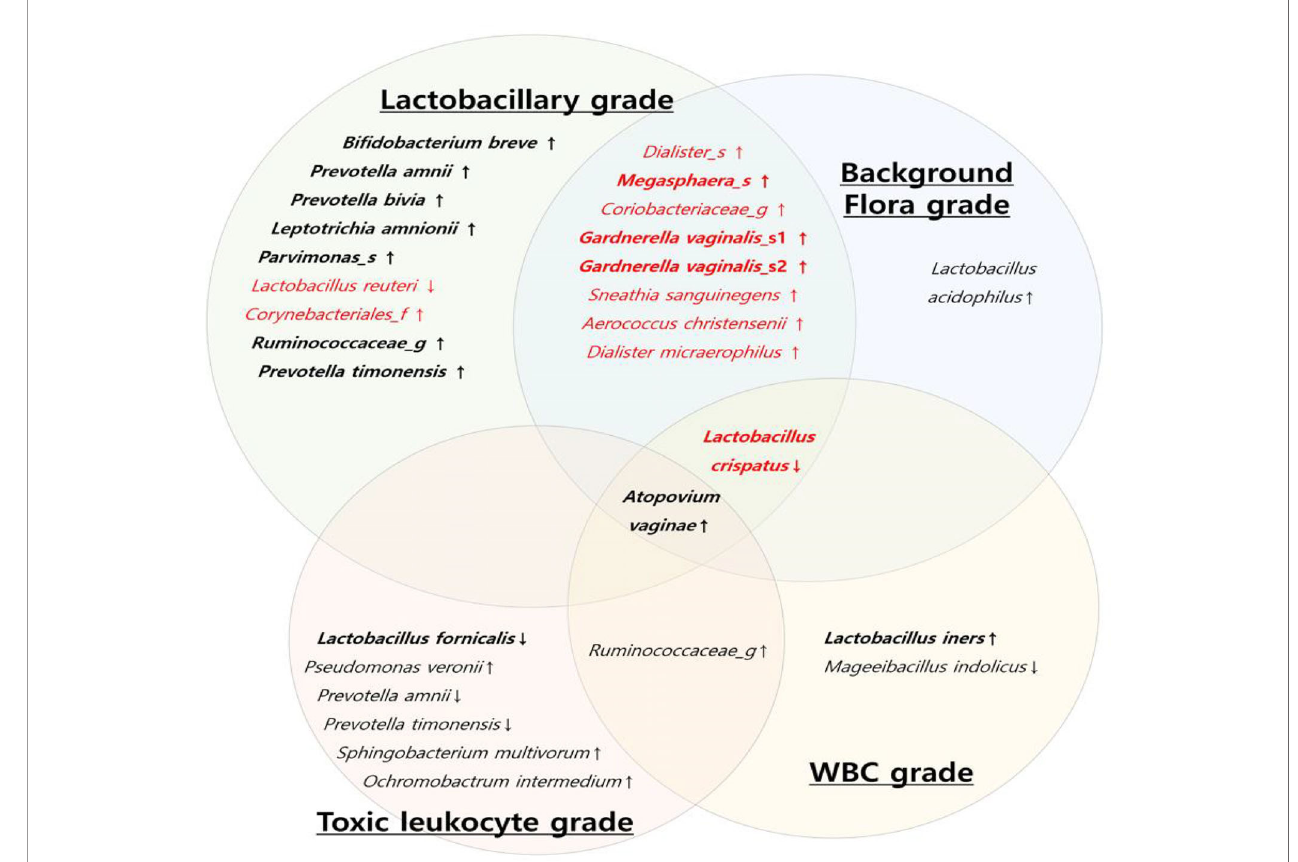
FIGURE 5 | Diagram of the vaginal microbial composition using each criterion of aerobic vaginitis scoring system. (Red letters: vaginal microbiota with a signi fi cant difference among the three AV groups (normal fl ora, mild aerobic vaginitis (AV), and moderate AV), black letters: vaginal microbiota with no signi fi cant difference in three AV groups,